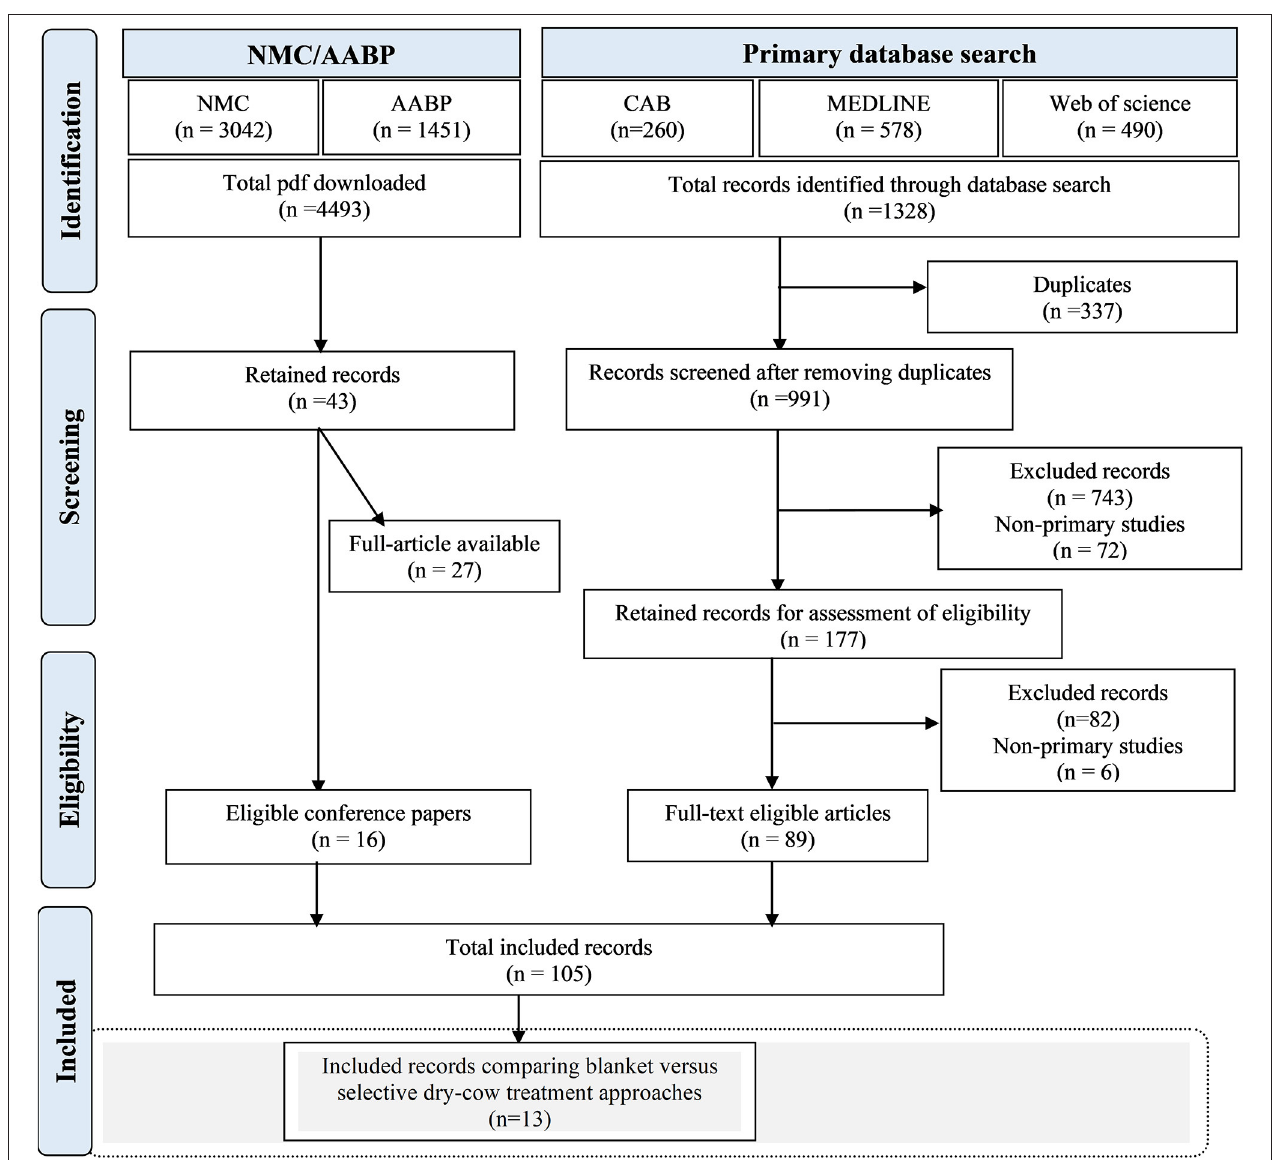
FIGURE 1 | Result of the different steps for searching and identifying relevant records for the systematic review and meta-analysis on antimicrobial-based dry cow therapy approaches. The search was conducted to answer three research objectives: (1) choice of antimicrobial at drying off; (2) comparison of blanket vs. selective dry cow treatment; and (3) complementing an antimicrobial treatment with a teat sealant. The gray box indicates results specific for objective (2), comparison of blanket vs. selective dry cow treatment, and the other two objectives will be presented in subsequent independent articles. Screening of references cited by the included articles was also conducted but did not lead to the addition of eligible articles specific to the comparison of selective and blanket dry cow therapies. This latter part of the search strategy will be presented for the other two objectives in the subsequent associated articles. NMC, National Mastitis Council; AABP, American Association of Bovine